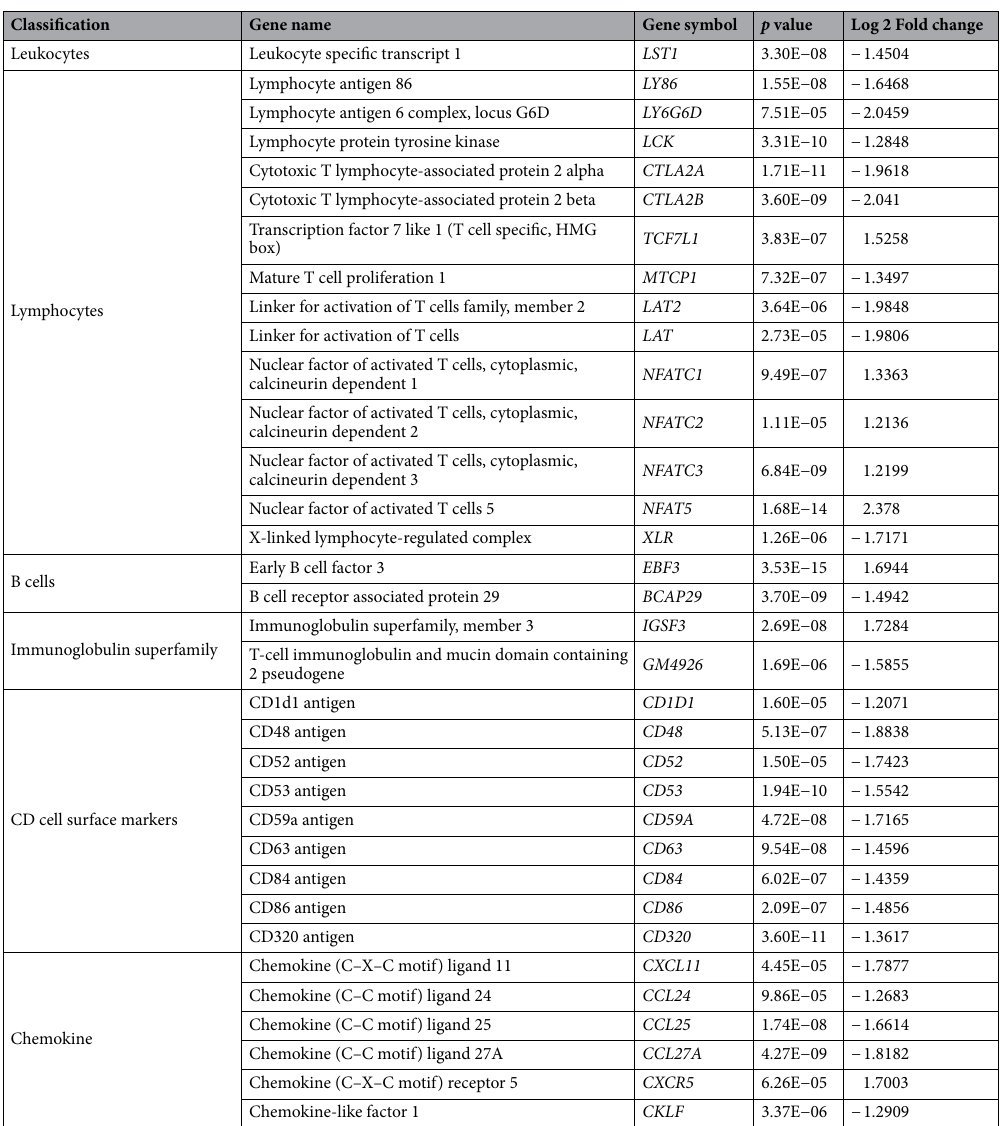
Table 3. List of adaptive immune system related genes differentially expressed in the pup brain, in response to maternal H. bakeri infection. Differential regulation as reported by Haque et al. 12